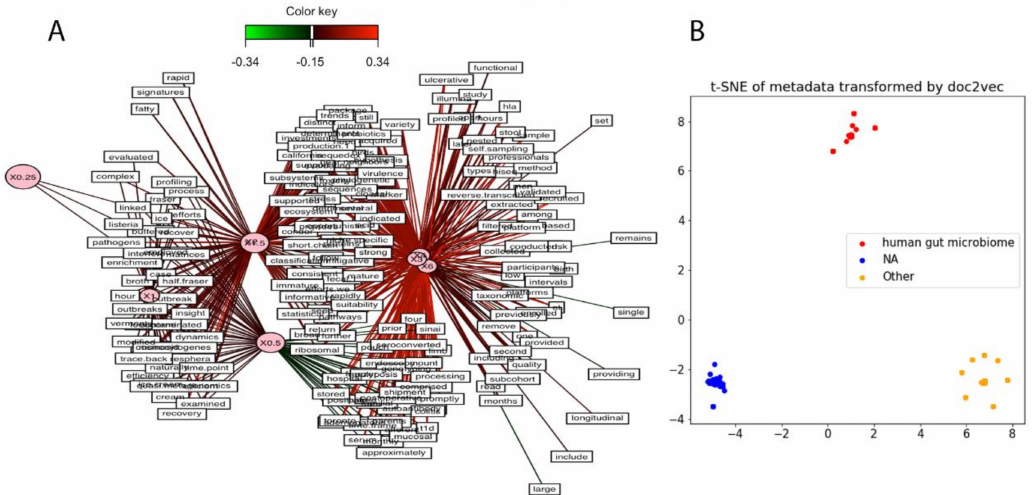
Figure 6. Next generation sequencing (NGS) classification using associated metadata. ( A ) Study abstract and metadata are insu ffi cient for NGS classification. Data sets where clustered using MASH, and partial least squares regression was performed to identify any covariance between the sequence content and word frequencies derived from the associated study abstracts and metadata; and ( B ) human gut microbiome samples are separable from other studies using Sequence Read Archive (SRA) metadata. Metadata was used as input to a word2vec model with 300 features, and the model was reduced to two dimensions using t-distributed stochastic neighbor